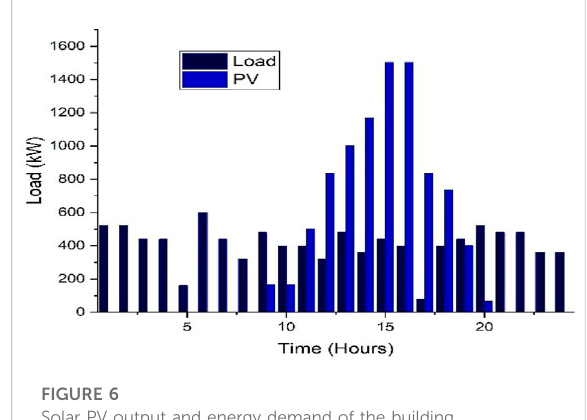
FIGURE 6 Solar PV output and energy demand of the